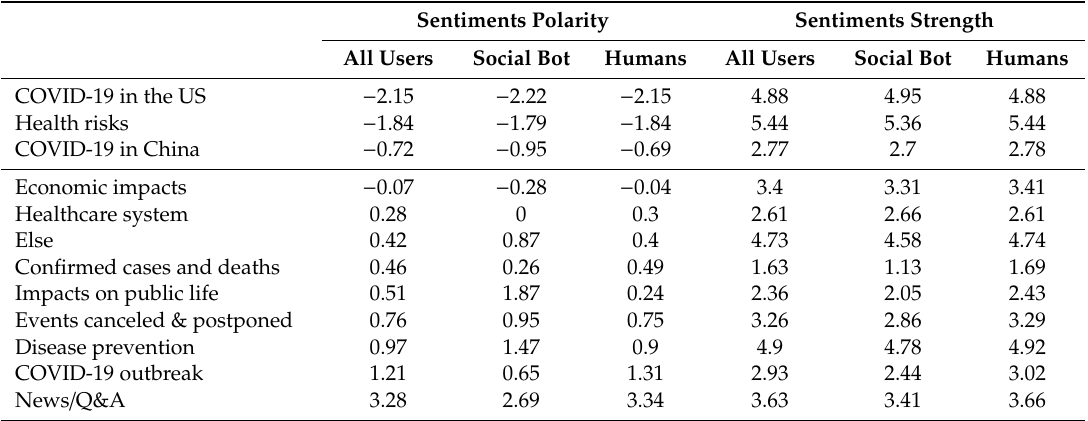
Table 2. Sentiments polarity and strength of all users, social bots, and humans for di ff erent topics. Sentiments Polarity Sentiments Strength All Users